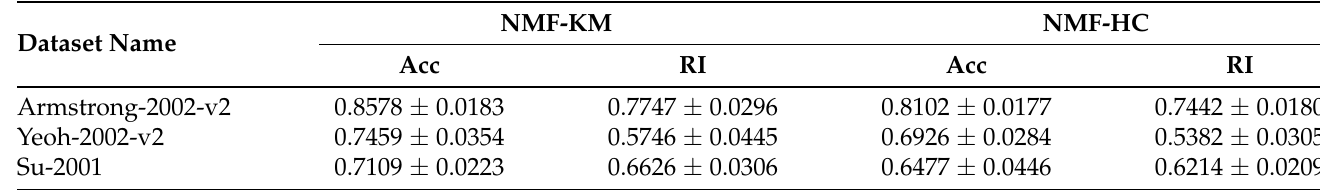
Table 2. Accuracy (Acc) and Adjusted Rand Index (RI) with NMF-KM and